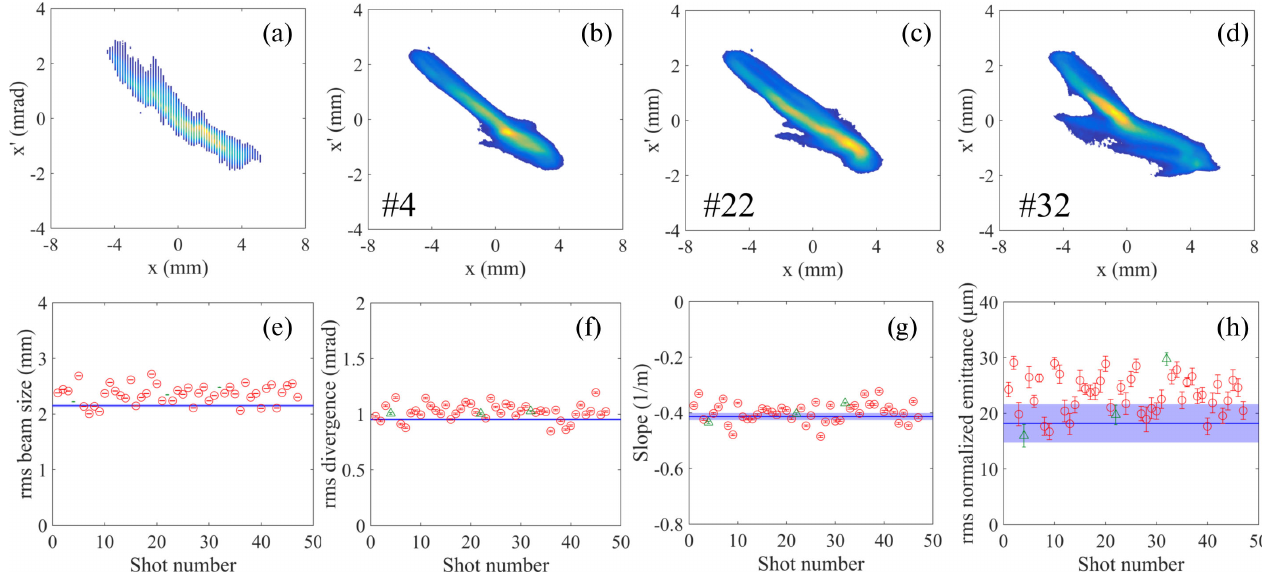
FIG. 10. Comparison of the averaged ( slit-scan ) and single-shot ( projection-based ) measurements. (a) Averaged TPS measured with the slit scan using 76 slit positions. (b) – (d) Single-shot TPS measured with the projection-based diagnostic. Each figure corresponds to the given shot numbers, whose charges are 1.63, 1.62, and 1.60 nC, respectively. (e) – (h) Horizontal beam parameters and their error estimated from the slit-scan (blue line, shade) and the projection-based diagnostic (red). Green triangles correspond to (b) –